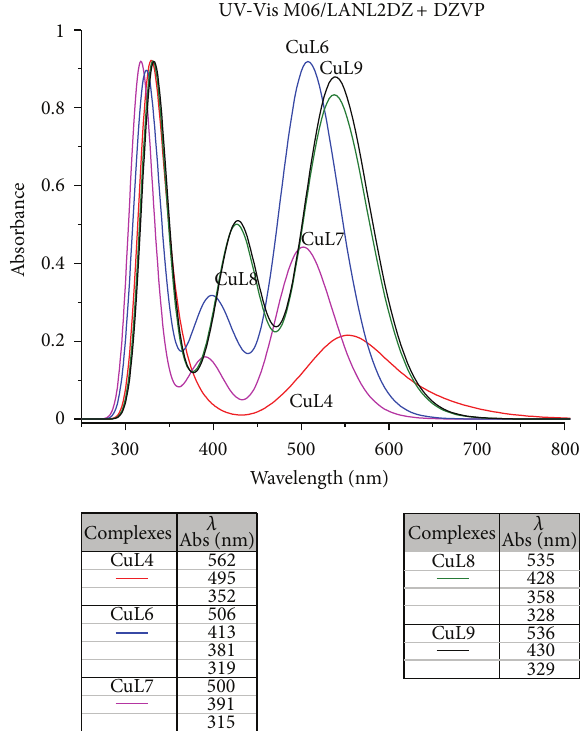
Figure 2: Ultraviolet-visible (UV-Vis) spectra of copper complexes analyzed in this study.